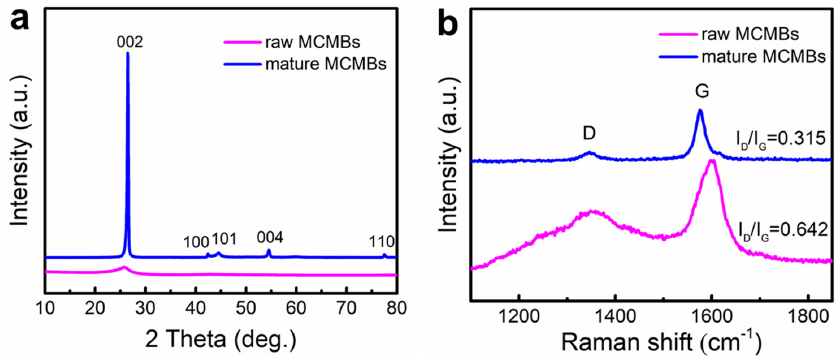
Figure 2. ( a ) XRD and ( b ) Raman patterns of the raw MCMBs and mature MCMBs.